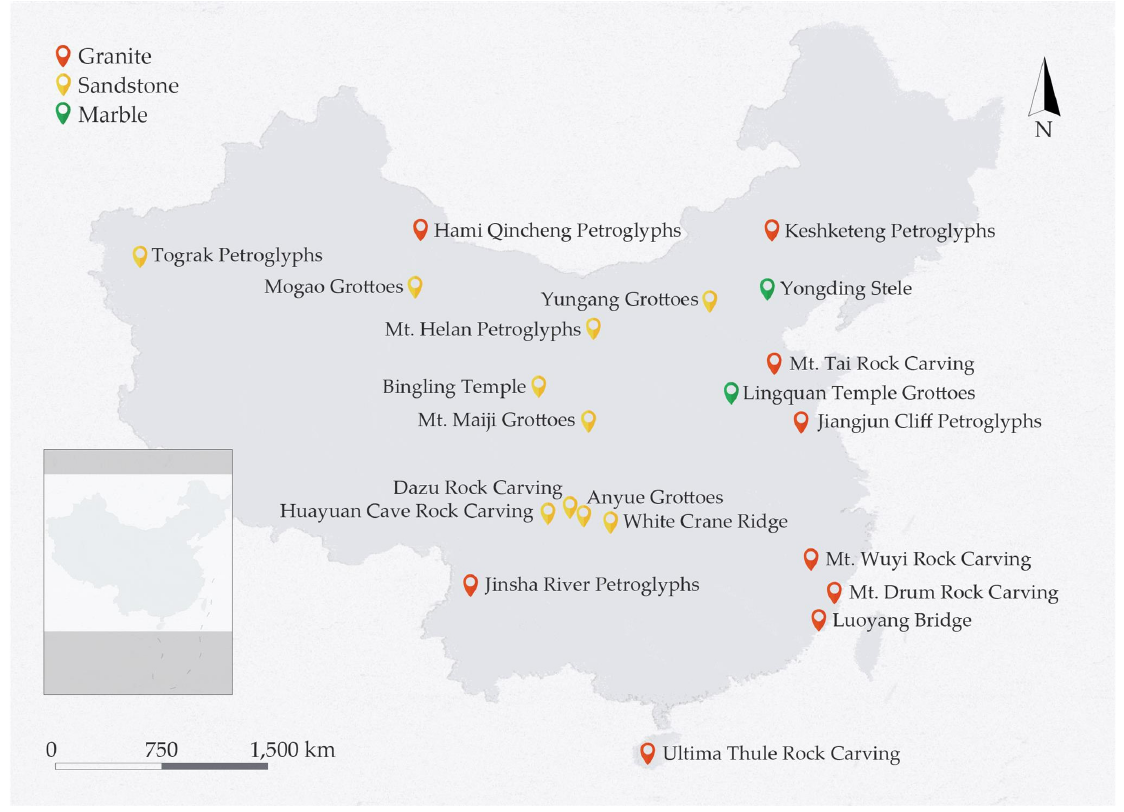
Figure 2. Distribution of sandstone-, marble-, and granite-related heritage sites in China.